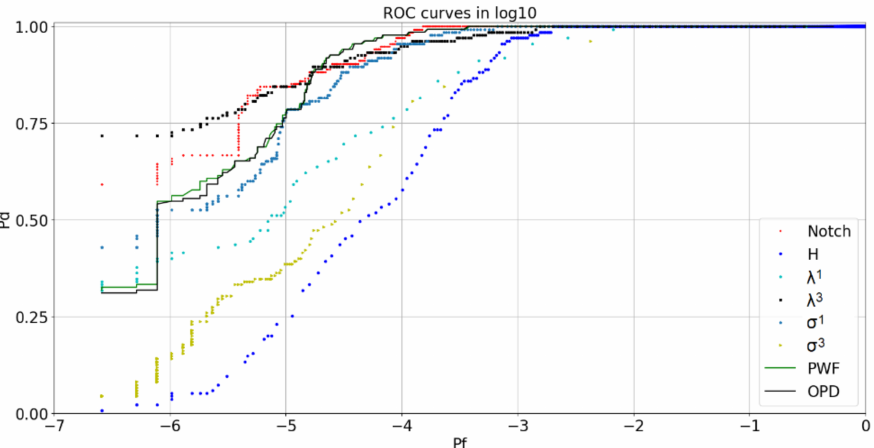
Figure 16. Iceberg detection ROC curves for sea ice, target window 5 × 5, clutter window 105 × 105 with no guard window. Notch means the polarimetric notch filter, H means entropy λ 1 and λ 3 are the first and third eigenvalues of the covariance matrix, σ 1 and σ 3 are from the polarimetric match filter, PWF means the polarimetric whitening filter, and OPD means the optimal polarimetric detector.